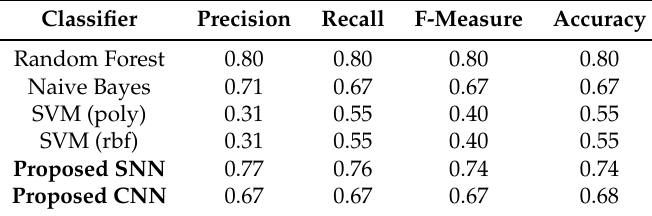
Table 7. Performance metrics for Amazon reviews, where SVM (poly): Support Vector Machine using a polynomial kernel, SVM (rbf): Support Vector Machine using a radial basis function kernel. Classifier Precision Recall